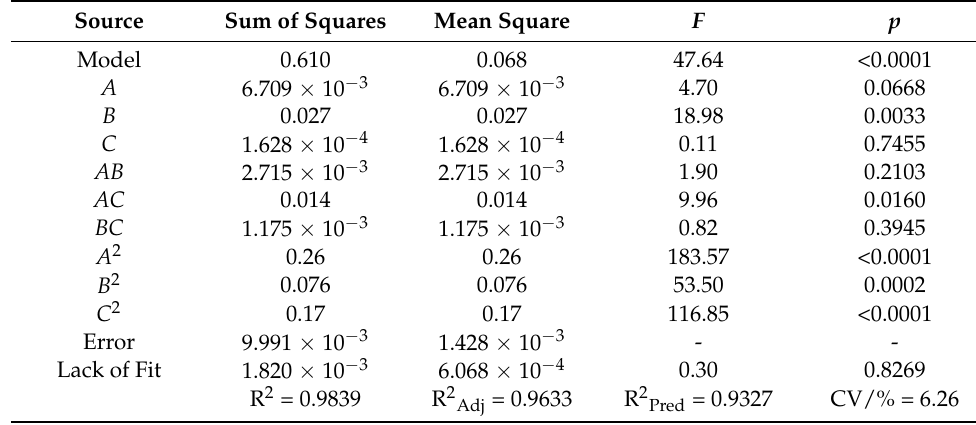
Table 7. ANOVA results for response surface model of